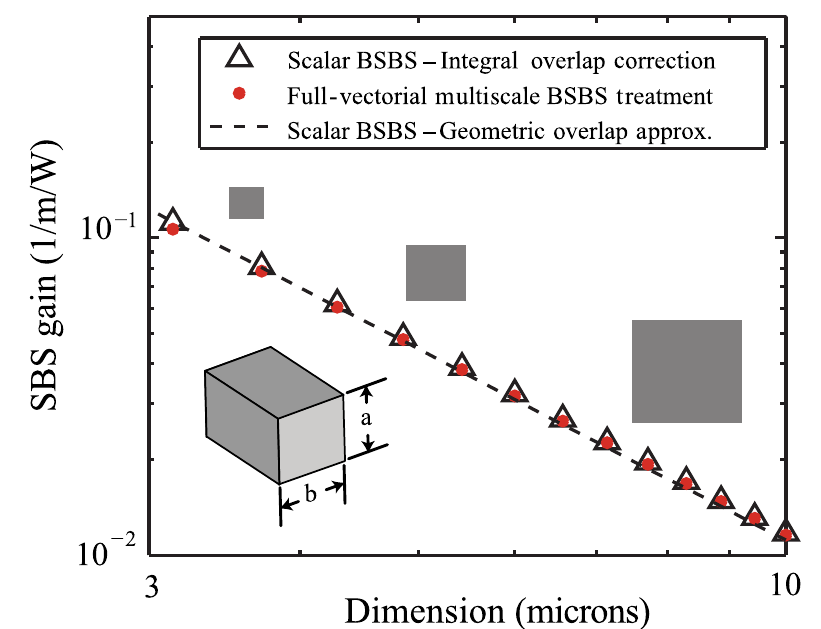
FIG. 6. Computed BSBS gain versus the waveguide dimension, a , for b ¼ 0 : 93 a . Comparison of a model based on MS-SBS theory (shown in red circles) is made with the integral form of the SBS gain (shown in triangles) and the simplified SBS trend (shown in